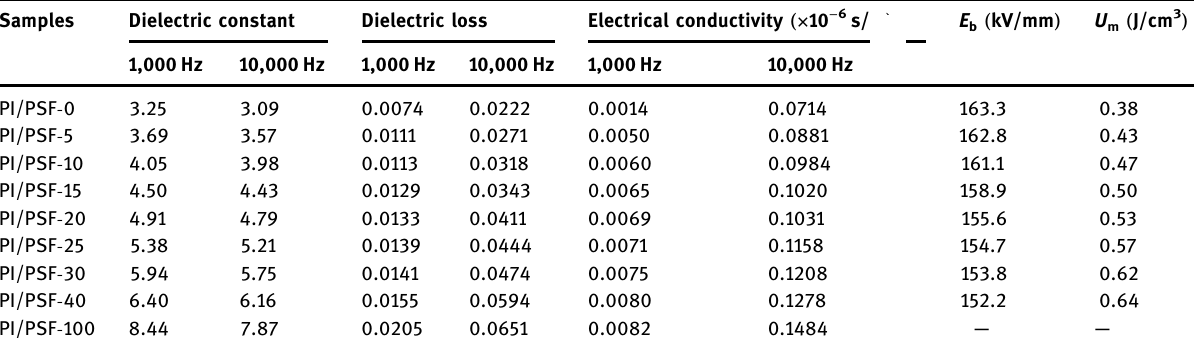
Table 1: Summary of dielectric properties of PI/PSF - X composite fi lms at 1,000 and 10,000 Hz Samples